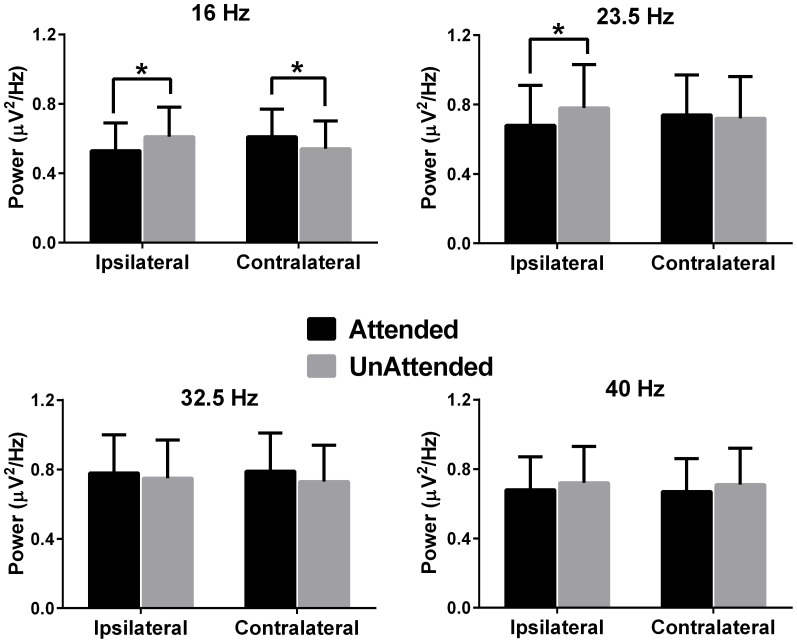
The bar graphs represent the absolute power measured from FFTs, when white noise was modulated with a particular modulation frequency and was attended or unattended.The bars represent neural activity from the ipsilateral and contralateral activations combined from T7 and T8 sites. An asterisk above the bar graphs indicates significant differences at p<.05.